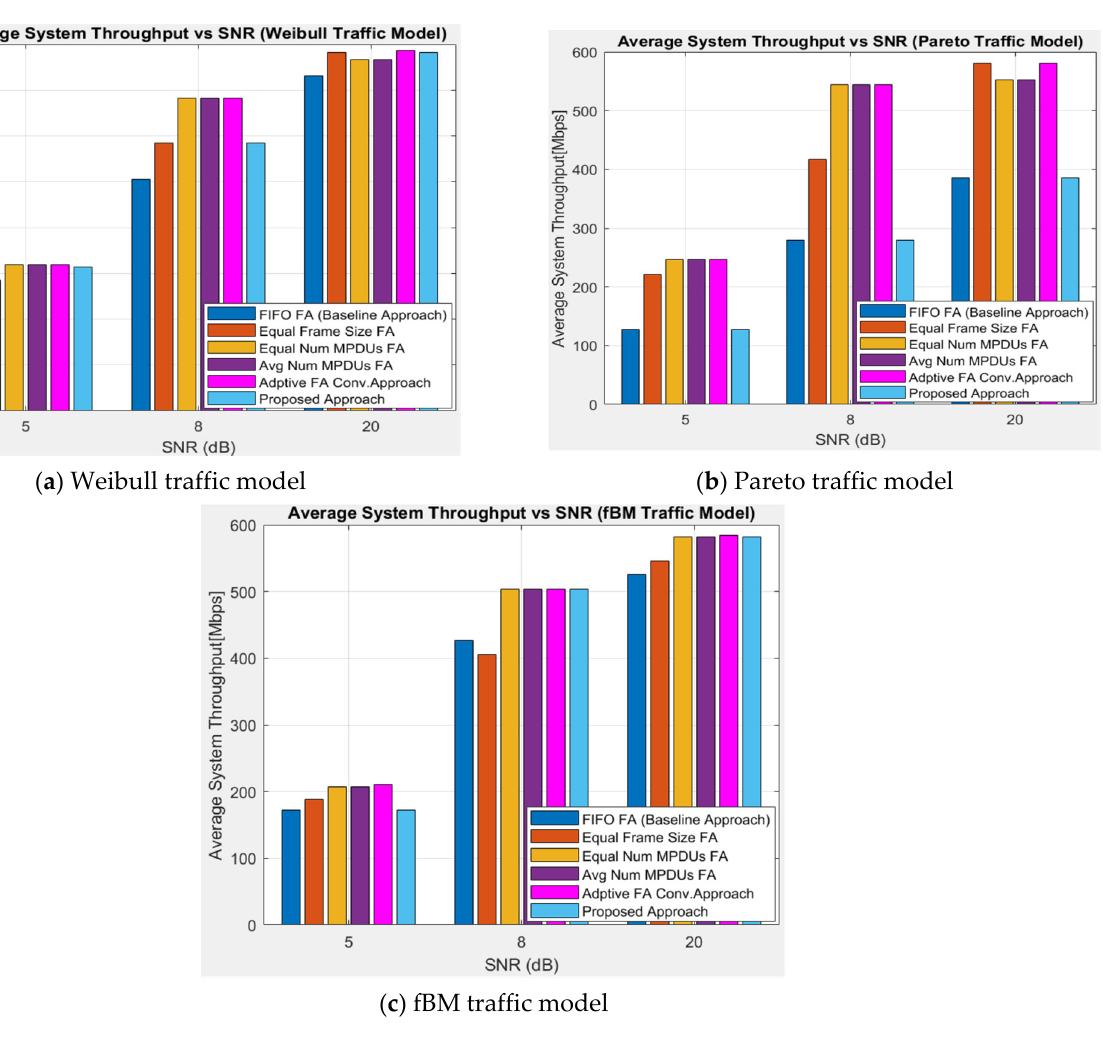
Figure 4. System throughput versus SNR for different traffic models such as Pareto, Weibull, and fBM when Num STAs =